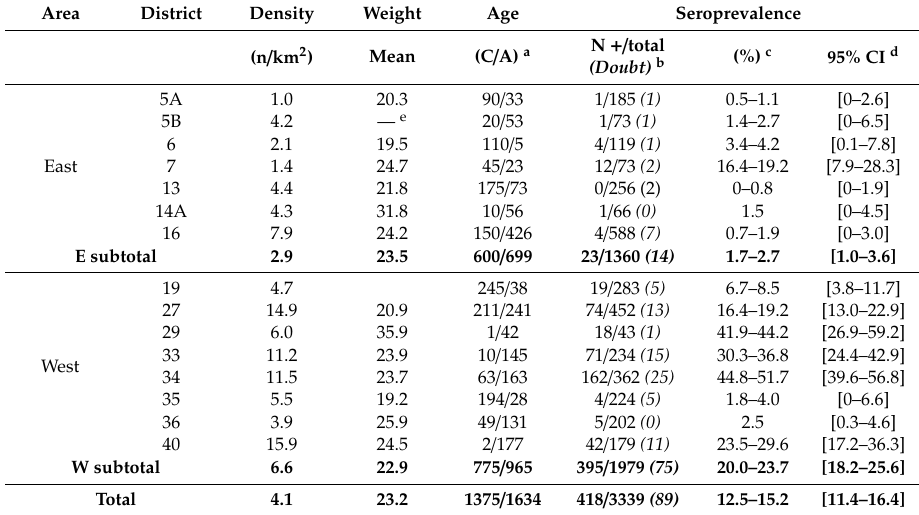
Figure 1. Distribution of percentage competition values for 3339 reindeer sera tested for antibodies against ruminant pestivirus using an ELISA. The density curve represents a kernel estimation of the probability density. The ELISA cut-off values are indicated in the graph by vertical lines; the dashed line (left) indicates a negative cut-off value of 20% and the dash-dot line (right) represents a positive cut-off value of 40%. Percentage competition values between 20% and 40% were considered doubtful. Table 1. Distribution of ruminant pestivirus seroprevalence according to reindeer herding district in Finnmark County,